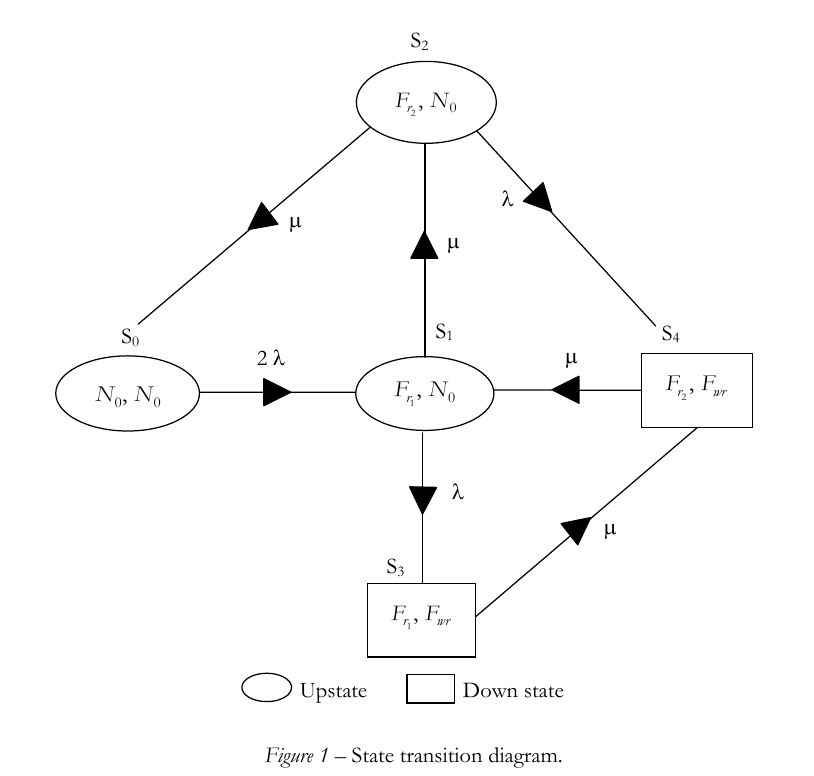
Figure 1 – State transition